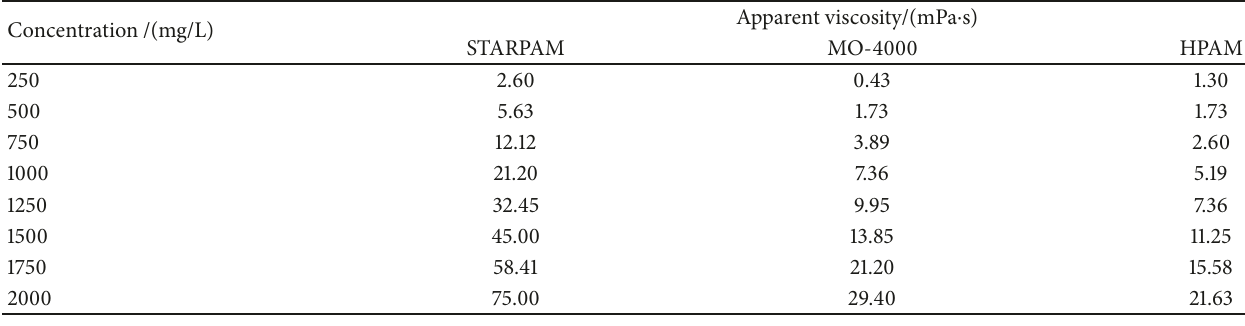
Table 2: Comparison of adding viscosity.